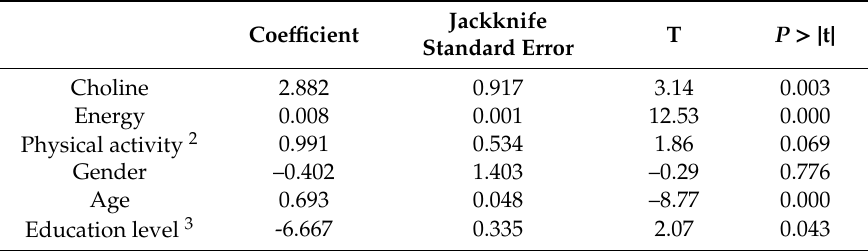
Table 4. Linear regression outcomes of the cereal-based products and dishes food group for choline intake in the 2011–12 NNPAS 1 ( n =